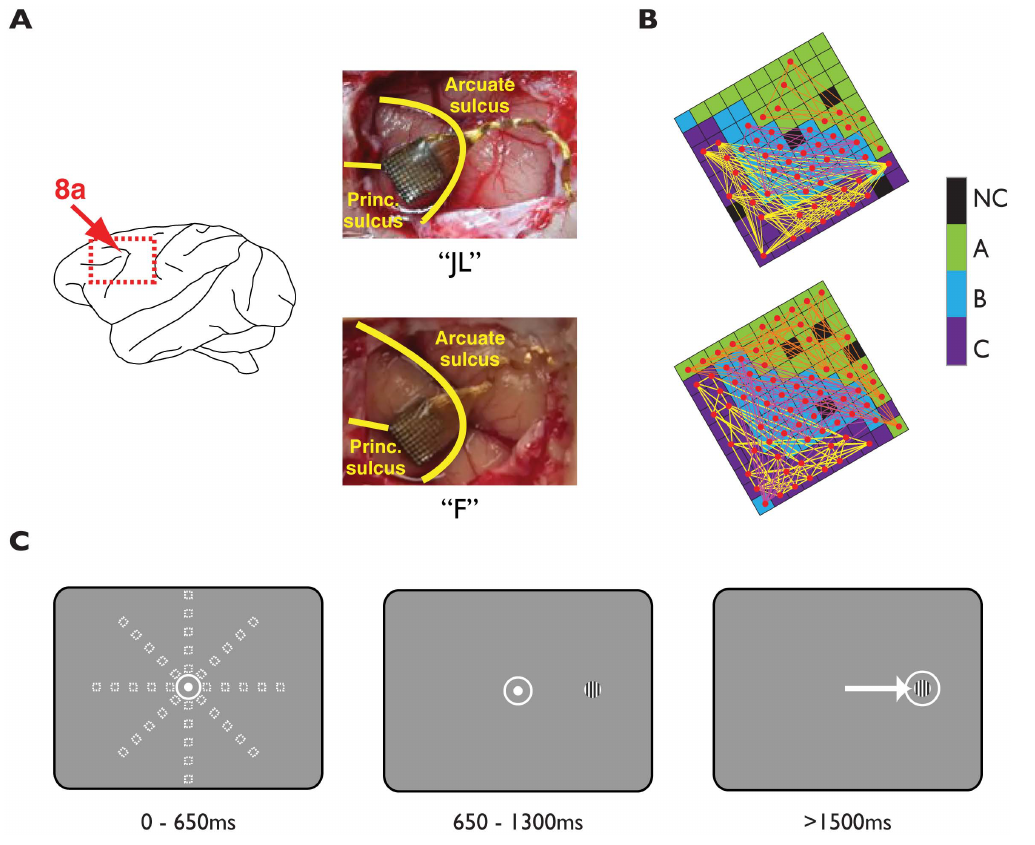
Figure 1. Locations of microelectrode array (MEA) implantations, task design, and correlation pairs on the MEA. A ) Pictures of the MEA implantation positions. Photographs were taken during the implantation procedure in monkeys ‘F’ and ‘JL’. Principal and arcuate sulci are indicated. B ) 32-channel recording blocks (‘A’, ‘B’, ‘C’) in each of the two implanted MEAs. Each square represents an electrode. Black squares are not connected (‘NC’). Red dots indicate single units and colored lines represent correlation pairings. C ) Time-course of events during an example trial. The grey window indicates the screen, the white dot the fixation spot, the squares the positions of the grating, and the white circles the fixation-window.